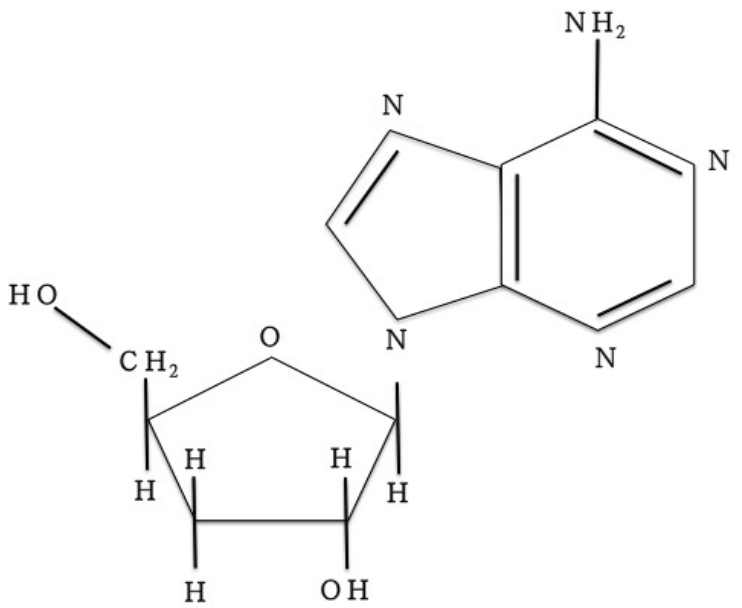
Figure 1. Chemical structures of cordycepin